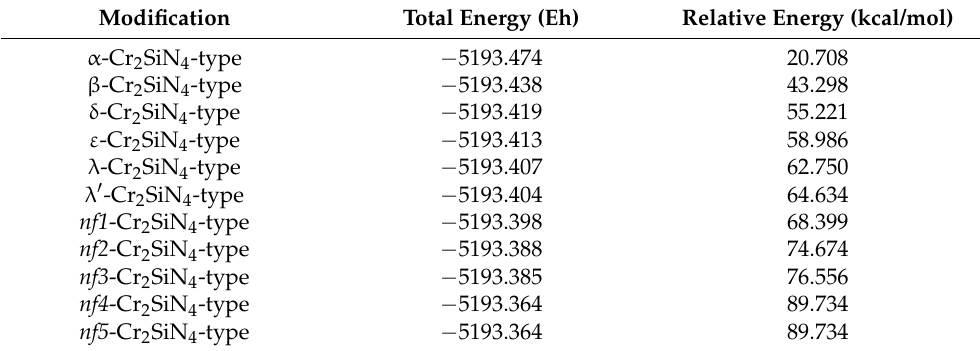
Table 1. The total energy (in Eh) and relative energy values (in kcal/mol) compared to the global minimum (spinel structure taken as the zero of energy) of Cr 2 SiN 4 modifications found after global optimization on an empirical potential level and locally optimized using the GGA-PBE functional.